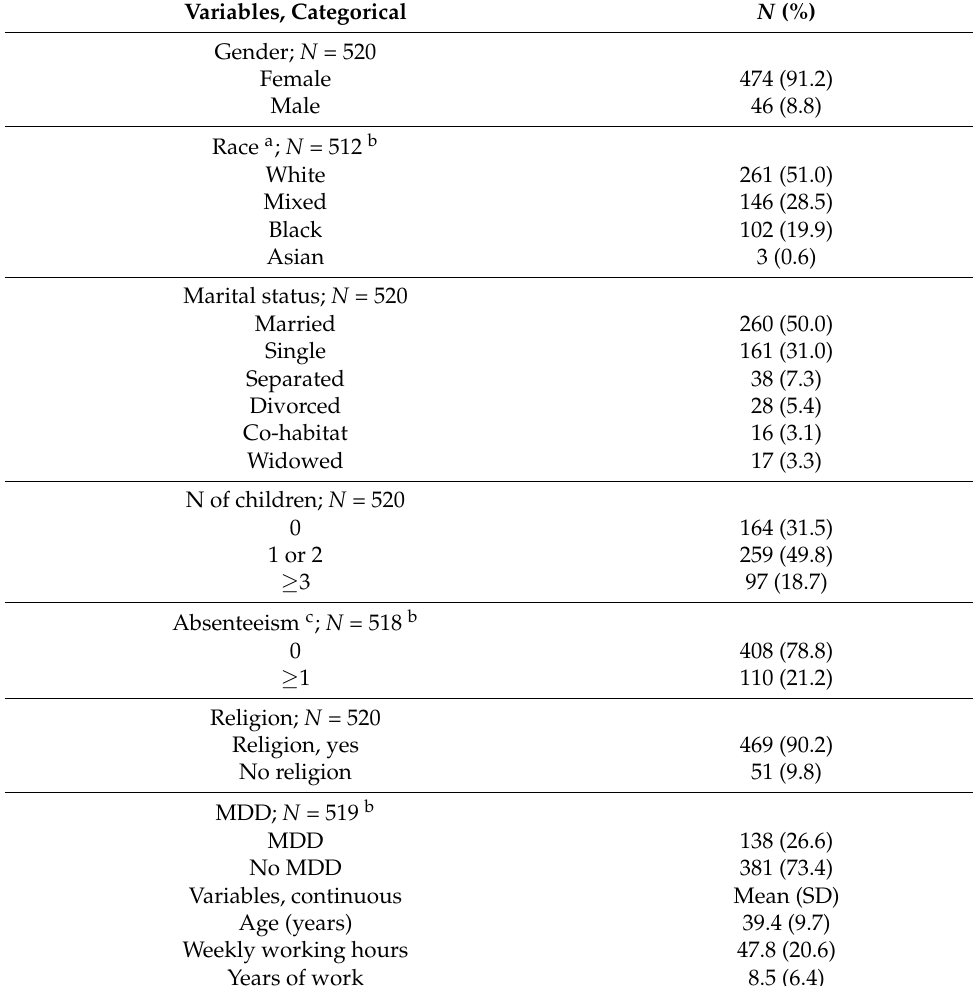
Table 1. Socio-demographic characteristics of nursing